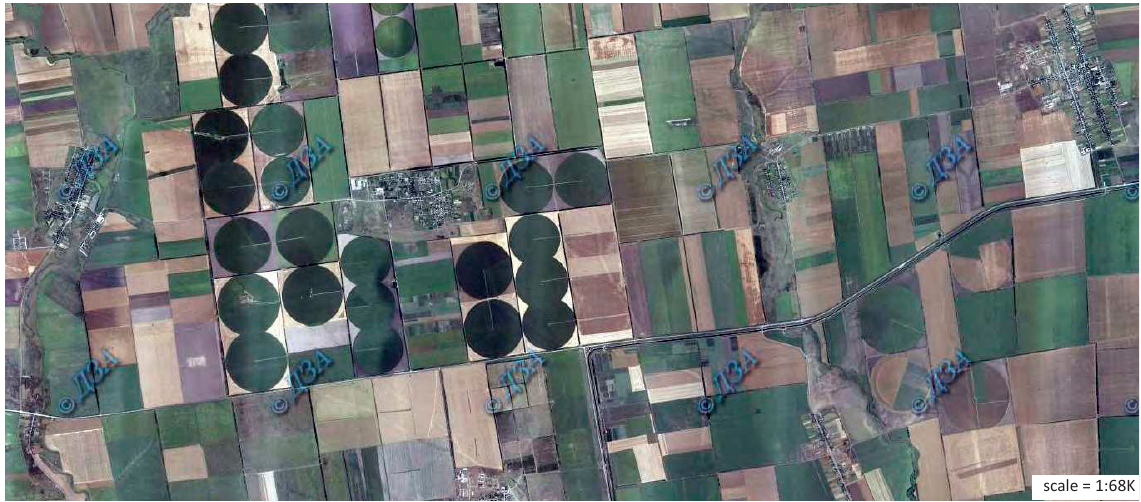
Figure 6. Orthophoto image of key plot On Figure 6, typical pattern of surge irrigation – green circles – can be seen easily. Some of these cir- cles are very contrast, thus owners of small land par- cels manage irrigation together or rent their land to a single farmer. Some of these circles on the right side of the image are hardly noticeable, then, irrigation was interrupted, but physical properties of cultivated soil were changed already.